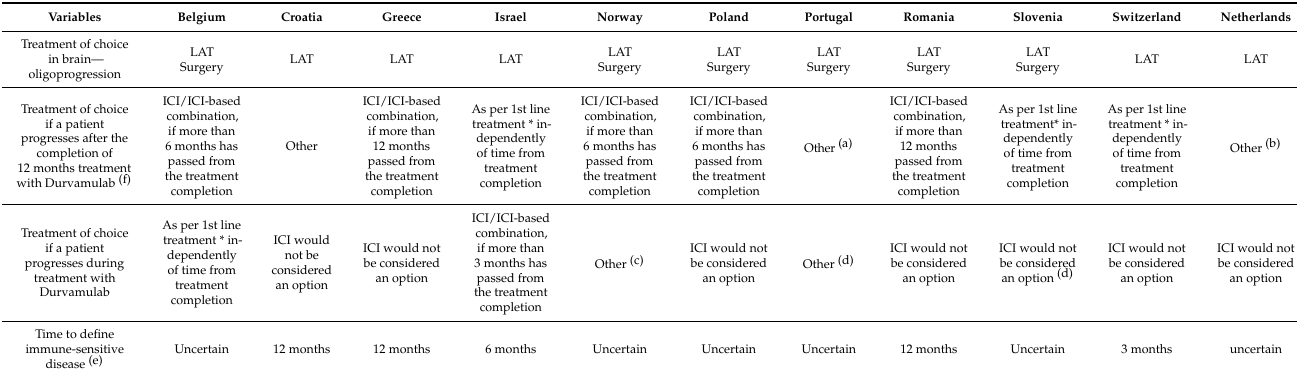
Table 6. Current dilemmas following Durvamulab